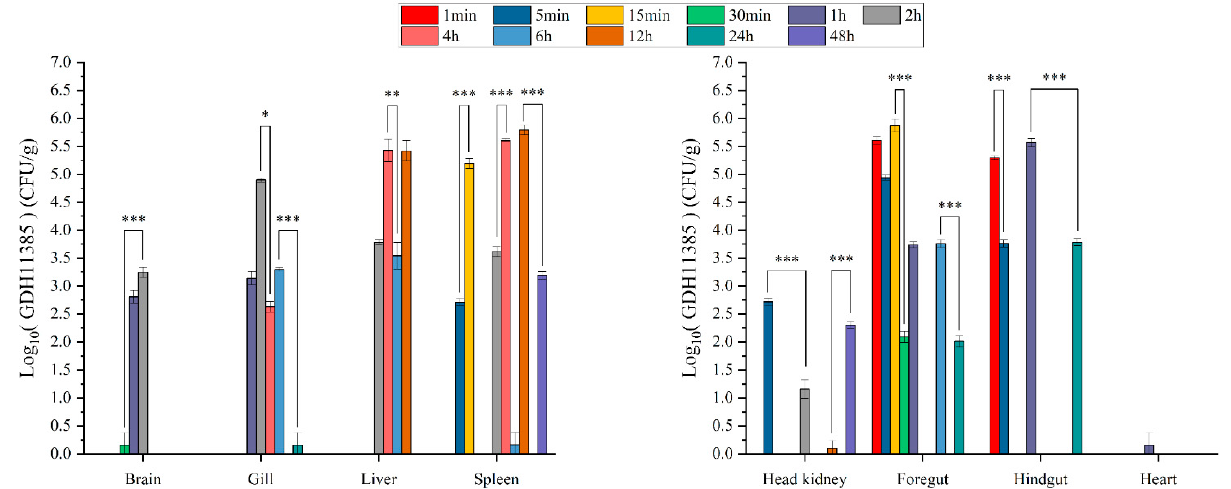
Figure 4. The distribution of GDH11385 in brain, liver, spleen, head kidney, gills, foregut, hindgut and heart of monoinfected hybrid groupers (group E) over 48 h postinjection. Data are shown as mean ± SD of three independent biological replicates. n.s., not significant; * p < 0.05, ** p < 0.01, *** p < 0.001.